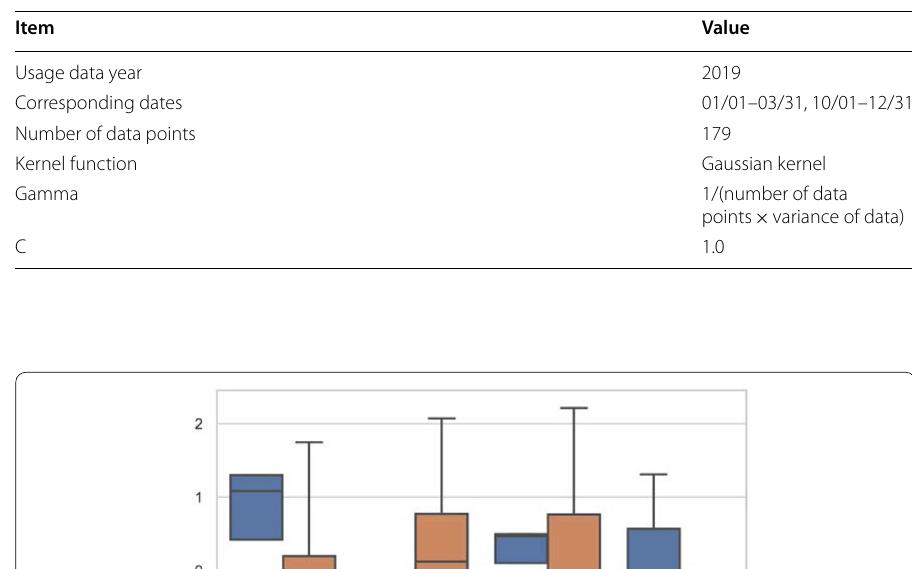
Table 5 Usage data and SVC parameters